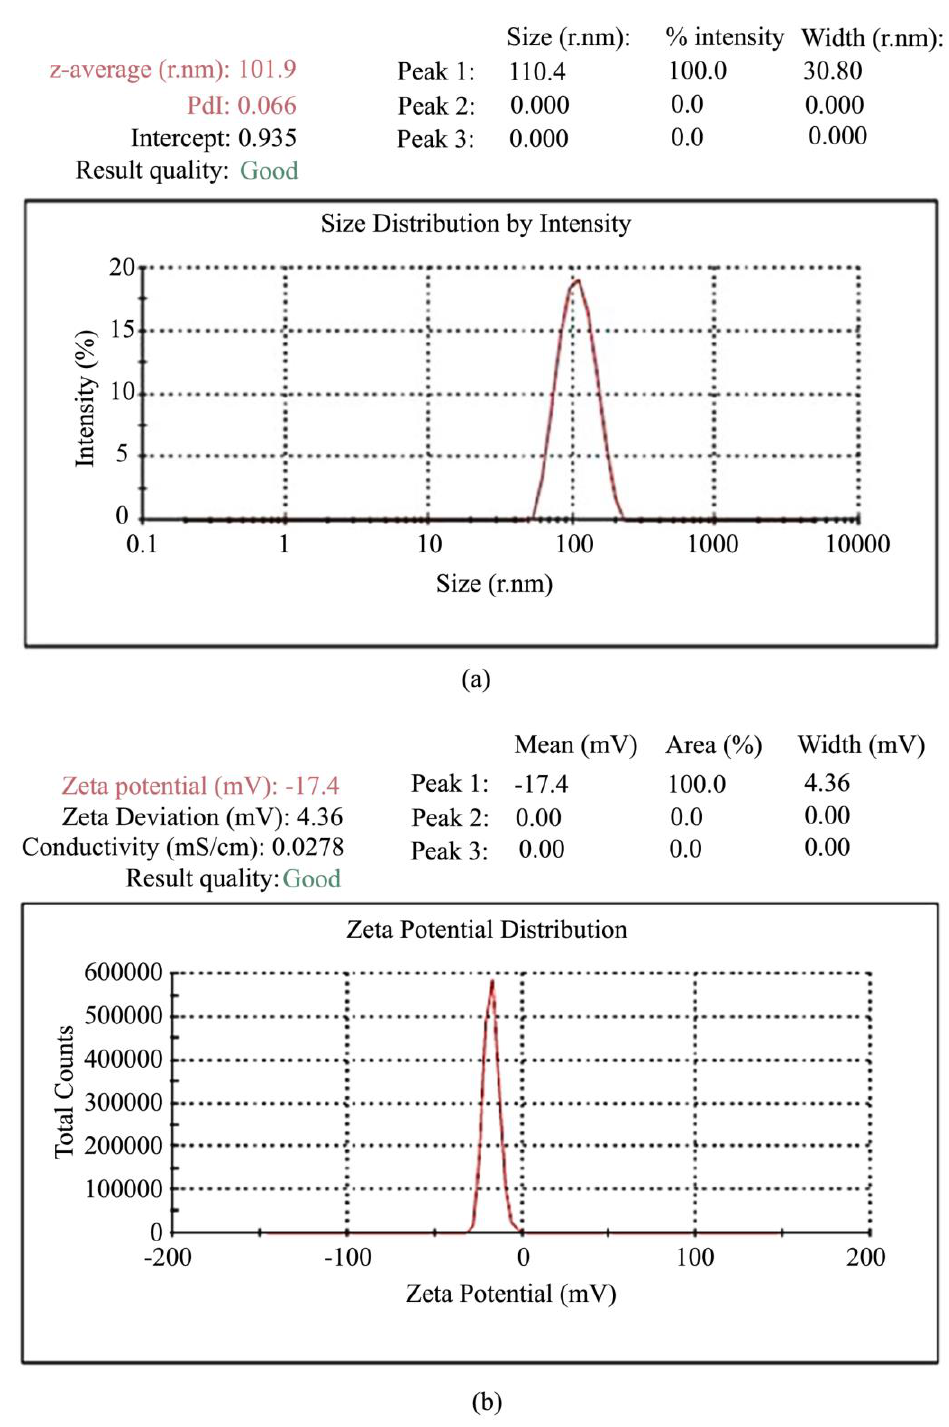
Figure 8. ( a ) Graph representing the particle size analysis and ( b ) Zeta potential of the optimized